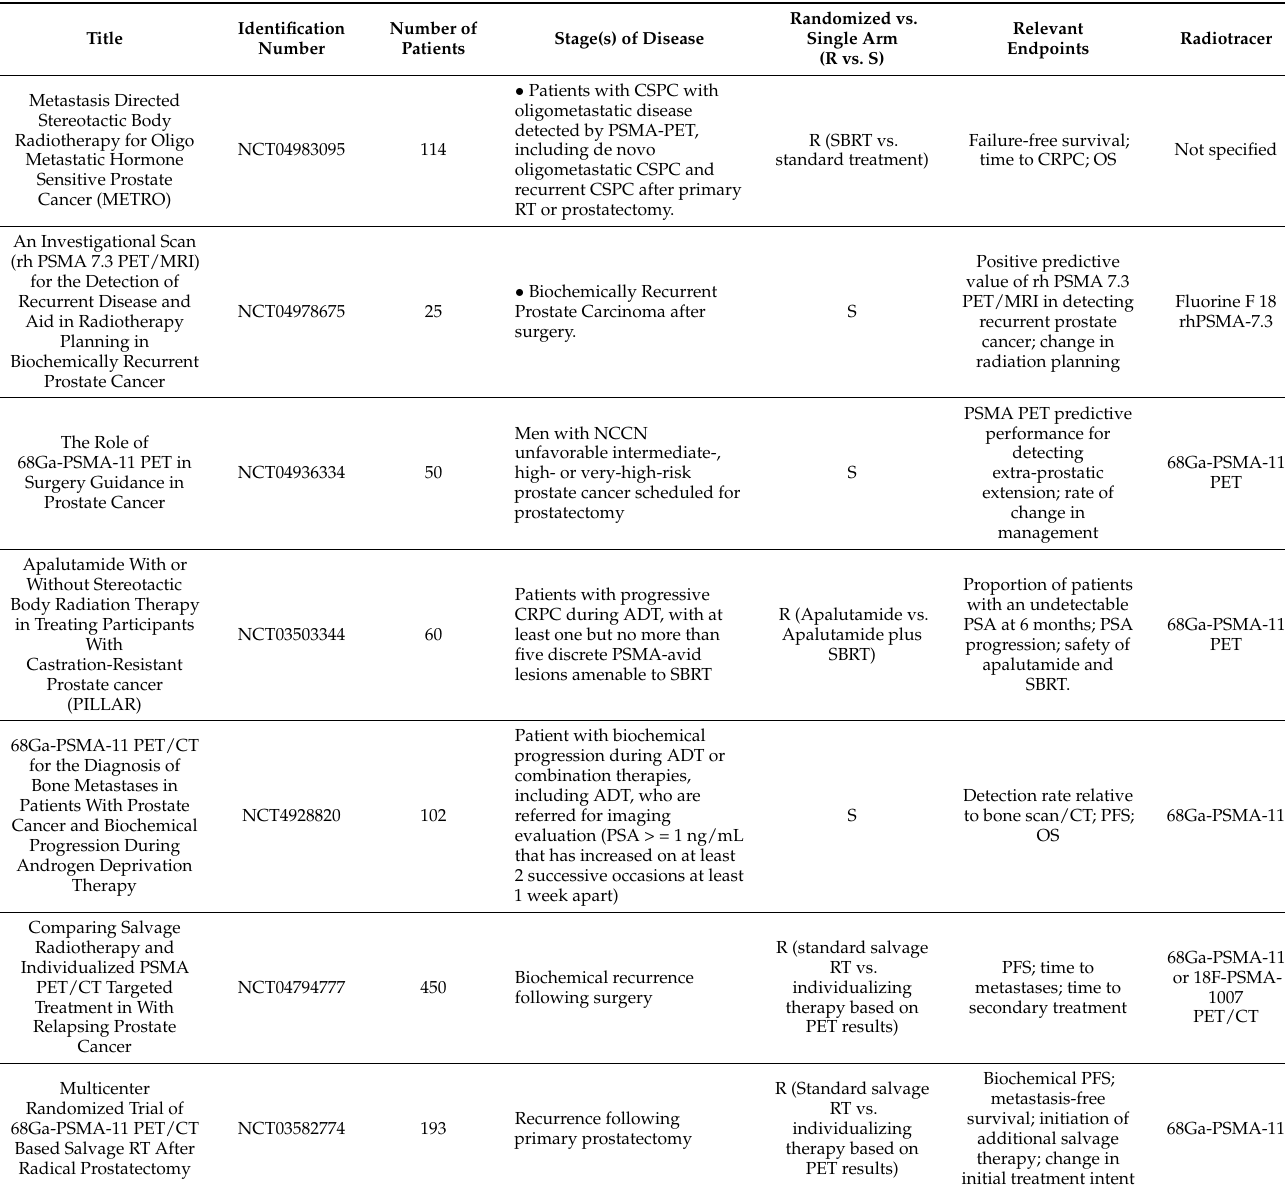
Table 3. Summary of relevant clinical trials using PSMA PET for patients with prostate